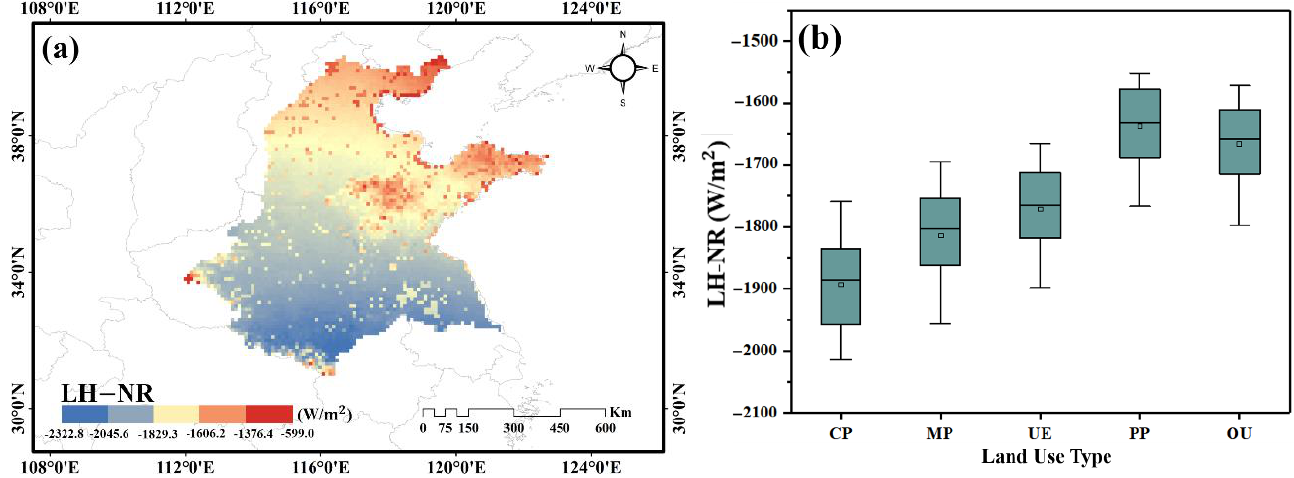
Figure 12. ( a ) Spatial variation (LH–NR) and ( b ) statistical values for the five land use types in the Huang-Huai-Hai River Basin from 2000 to